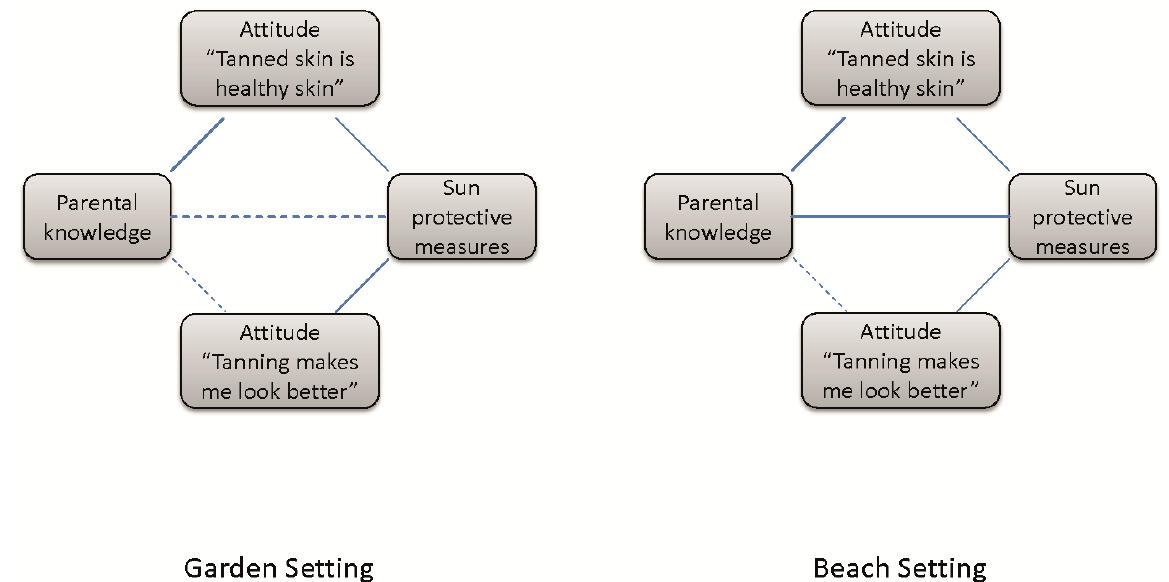
Figure 1. The relationship between parental knowledge, attitudes towards tanning and sun protective measures—visualization of results from log-linear modeling (see